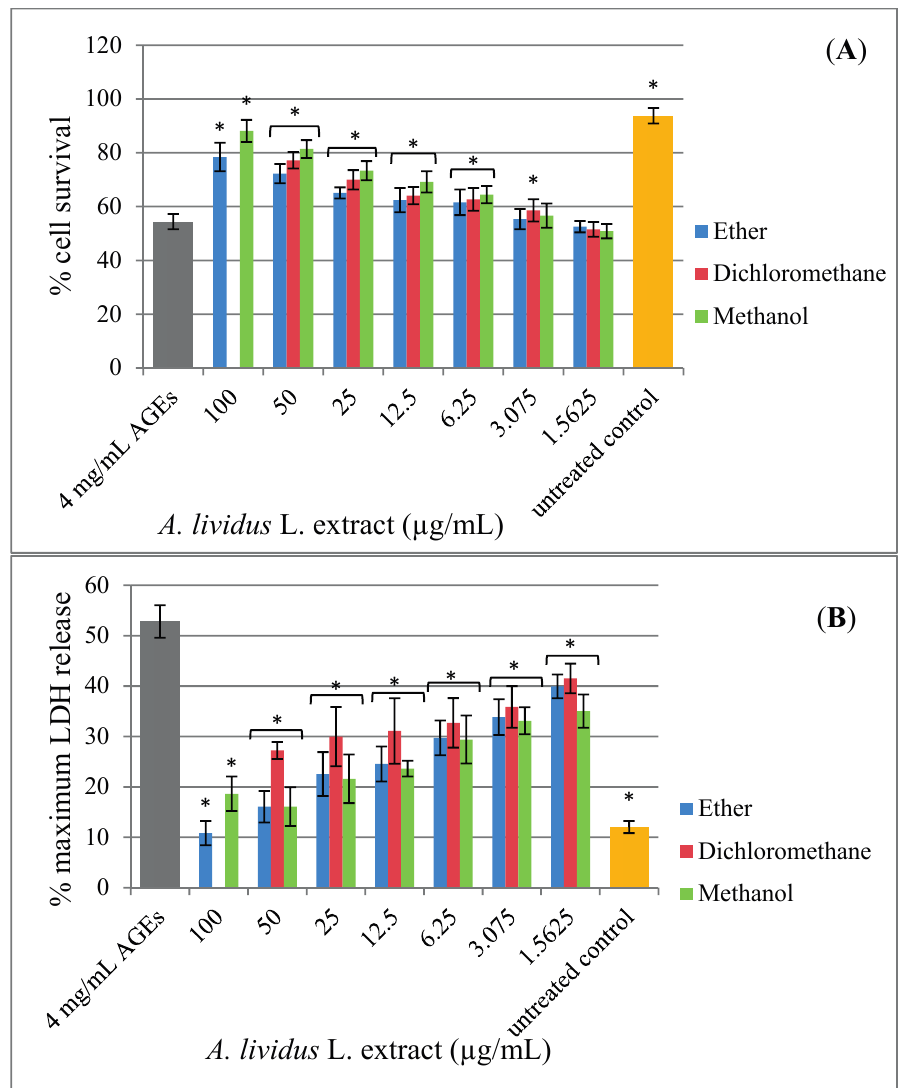
Figure 4. Protective effect of A. lividus L. extracts on AGEs-induced cytotoxicity in SH-SY5Y cells. SH-SY5Y cells were preincubated with A. lividus L. for 24 h and then further incubated with AGEs for 48 h. ( A ) The cell survival of living SH-SY5Y cells was assessed using the trypan blue exclusion assay. ( B ) The release of LDH from damaged SH-SY5Y cells was assessed using the LDH assay. Values are reported as the means with their standard error of the mean (SEM), depicted by vertical bars. All experiments were performed in triplicate (N = 3). * p < 0.05 for a significant change as compared to AGEs treatment